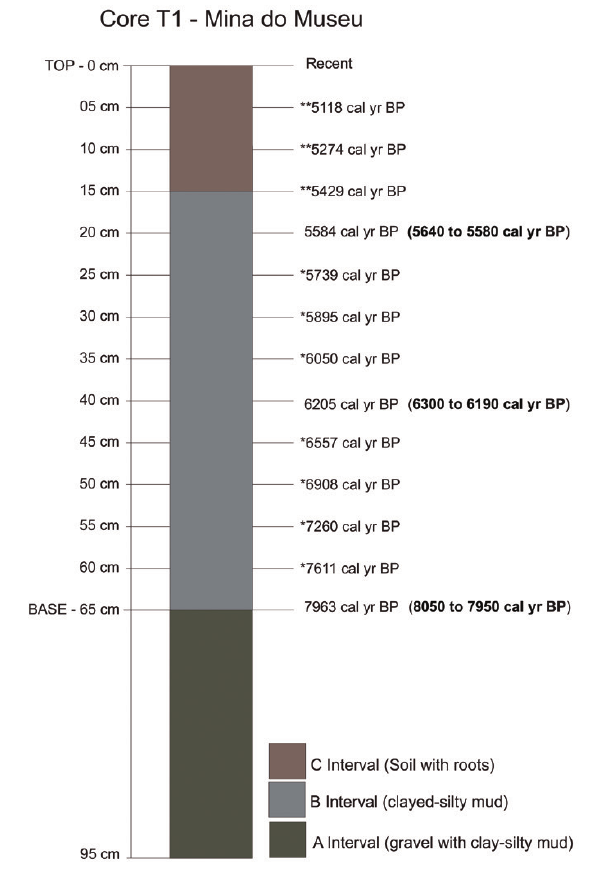
Fig. 3 - Chronological framework for the sedimentary profile of the T1 core (Mina do Museu) showing the calibrated radiocarbonic age (cal yr BP), the interpolated ages (*) and the extrapolated ages (**). The analyses performed by Beta Analytic are highlighted in bold. The other ages are calculated as the median